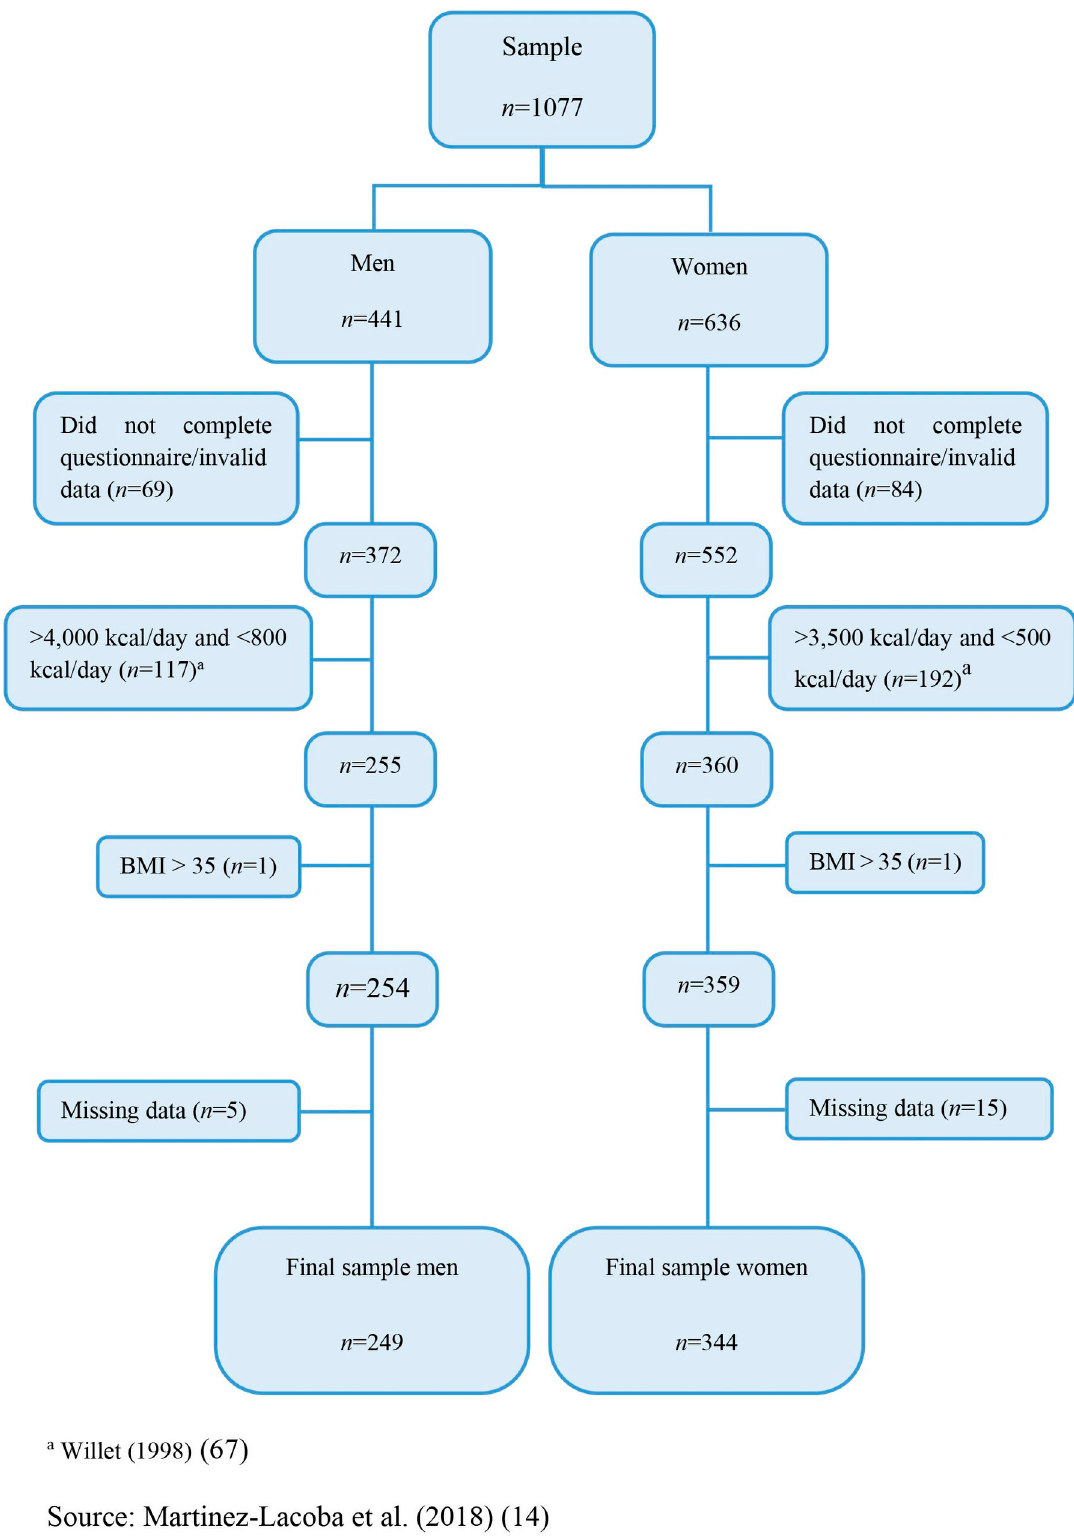
Fig 1. Data cleaning